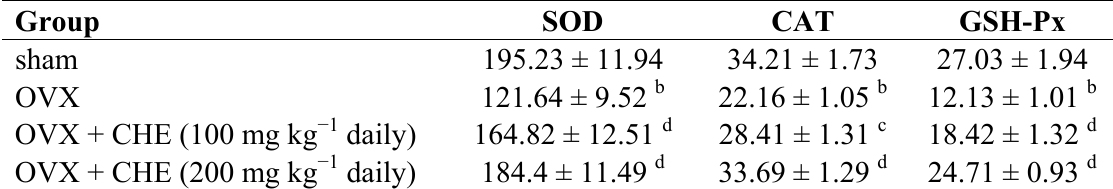
Table 5. Effect of Cistanches Herba extract treatment on blood superoxide dismulase ( SOD), catalase (CAT) and glutathione peroxidase (GSH-Px) activities.